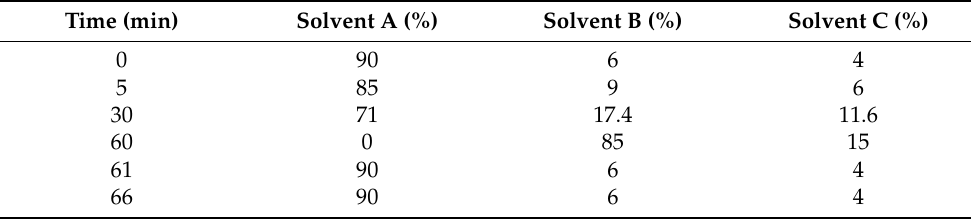
Table 4. A gradient solvent system of high-performance liquid chromatography (HPLC). Time (min) Solvent A (%) Solvent B (%) Solvent C (%) 0